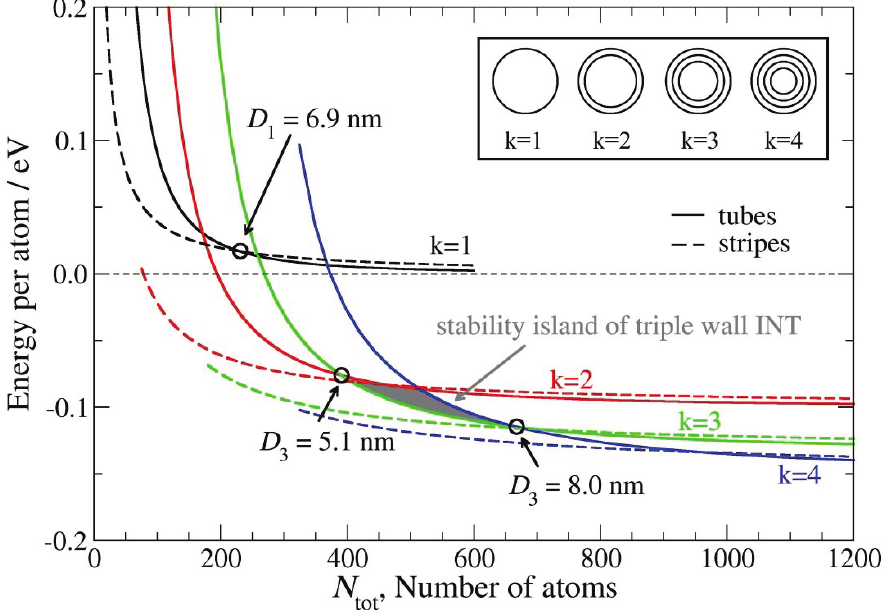
Figure 1. The calculated energy-per-atom for MoS 1–4 walls as a function of the number of atoms in the tube unit cell, N